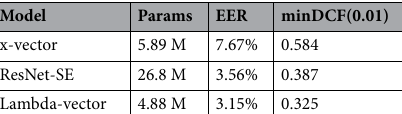
Table 4. Results of x-vector, ResNet-SE and Lambda-vector models on Voxceleb1 test set. M for Million.